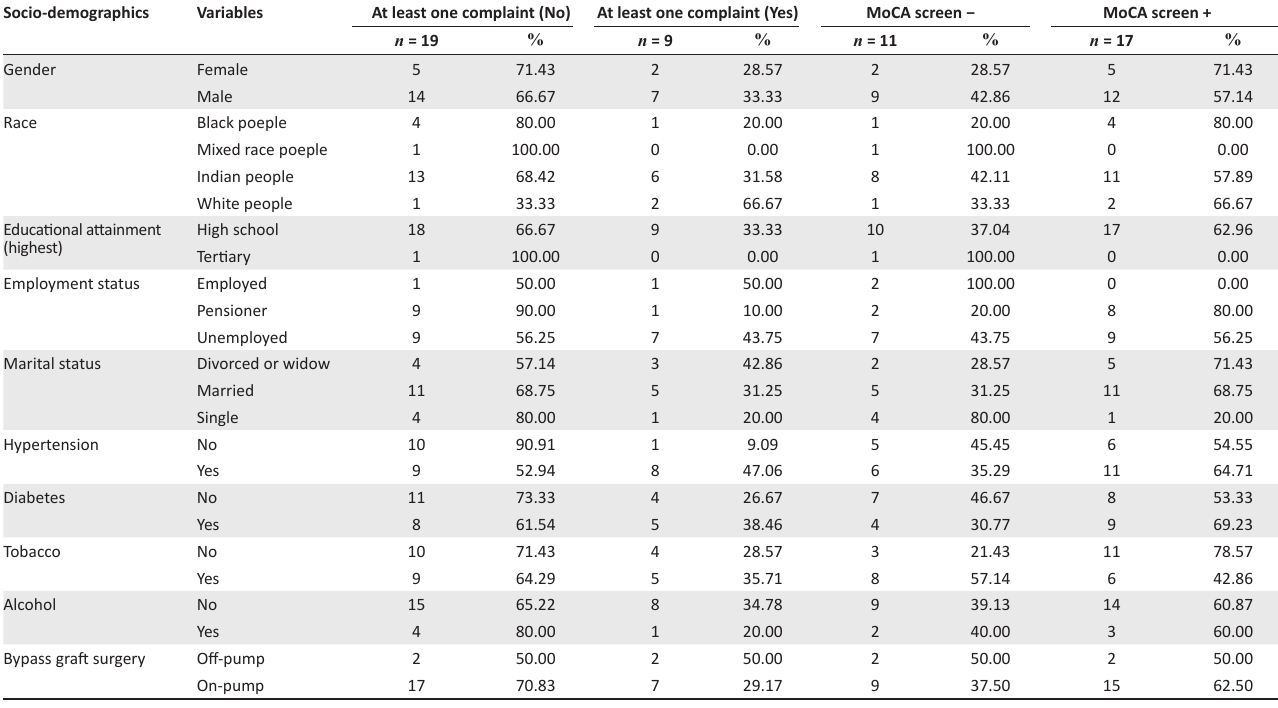
TABLE 3: Socio-demographic and clinical profile distribution by subjective and objective cognition status ( N = 28).